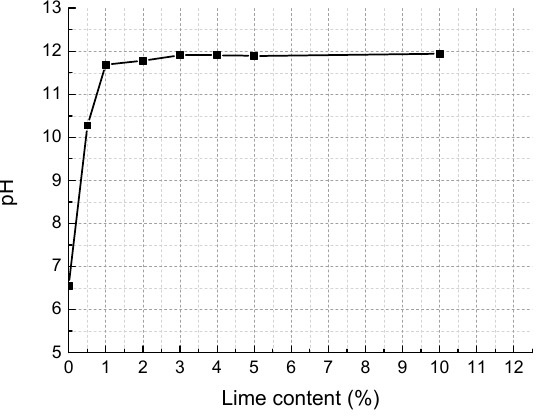
Figure 4. pH variation with lime content.